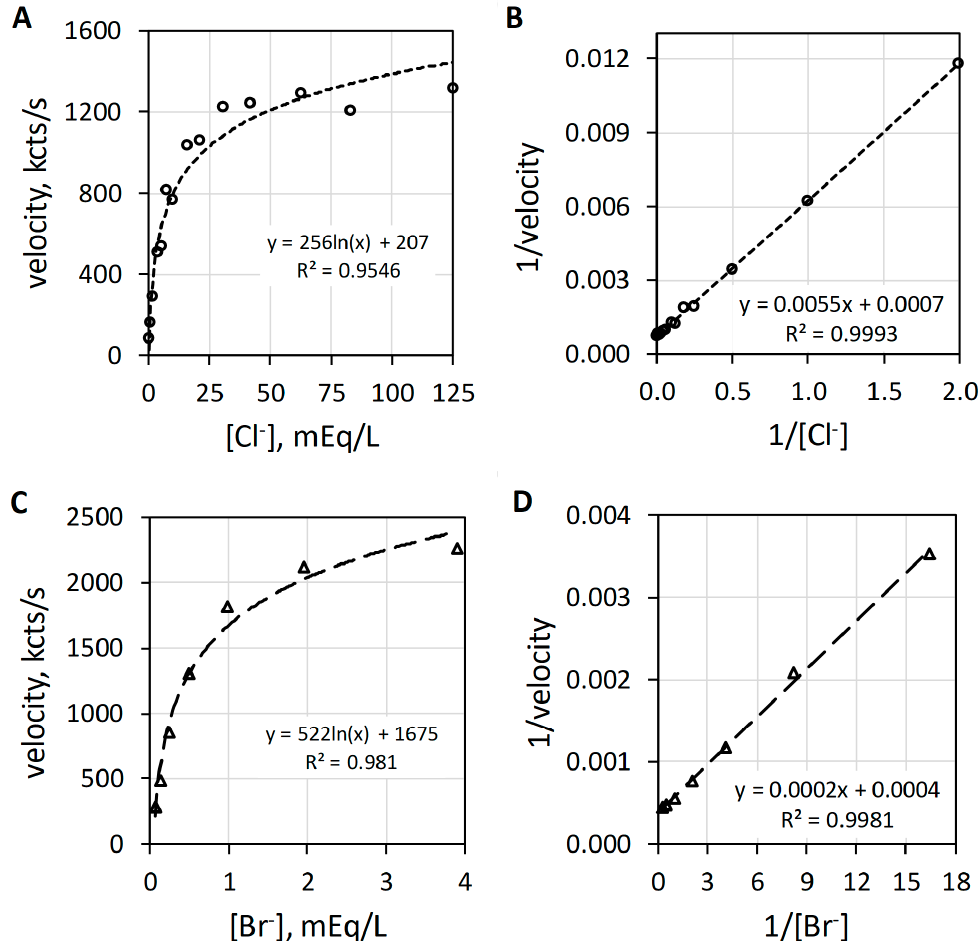
Figure 3. Plots of MPO-catalyzed luminol luminescence against halide concentration expressed in milliequivalents per liter (mEq/L). ( A ) shows the hyperbolic relationship of velocity to increasing [Cl − ] (mEq/L). ( B ) presents the double reciprocal plot of 1/velocity (1/(kcts/s)) against 1/[Cl − ] (1/(mEq/L)) showing proper linearity. ( C ) depicts the hyperbolic response to increasing [Br − ] (mEq/L). ( D ) shows the double reciprocal plot of 1/velocity (1/(kcts/s)) against 1/[Br − ] (1/(mEq/L)) showing suitable linearity. Cl − and Br − concentrations were varied with a constant concentration of 78 nM MPO, 51 µ M luminol, and 6.3 mM H 2 O 2 in 50 mM acetate buffer pH 5. Reaction was initiated by mixing of reactants. The final volume was 1.0